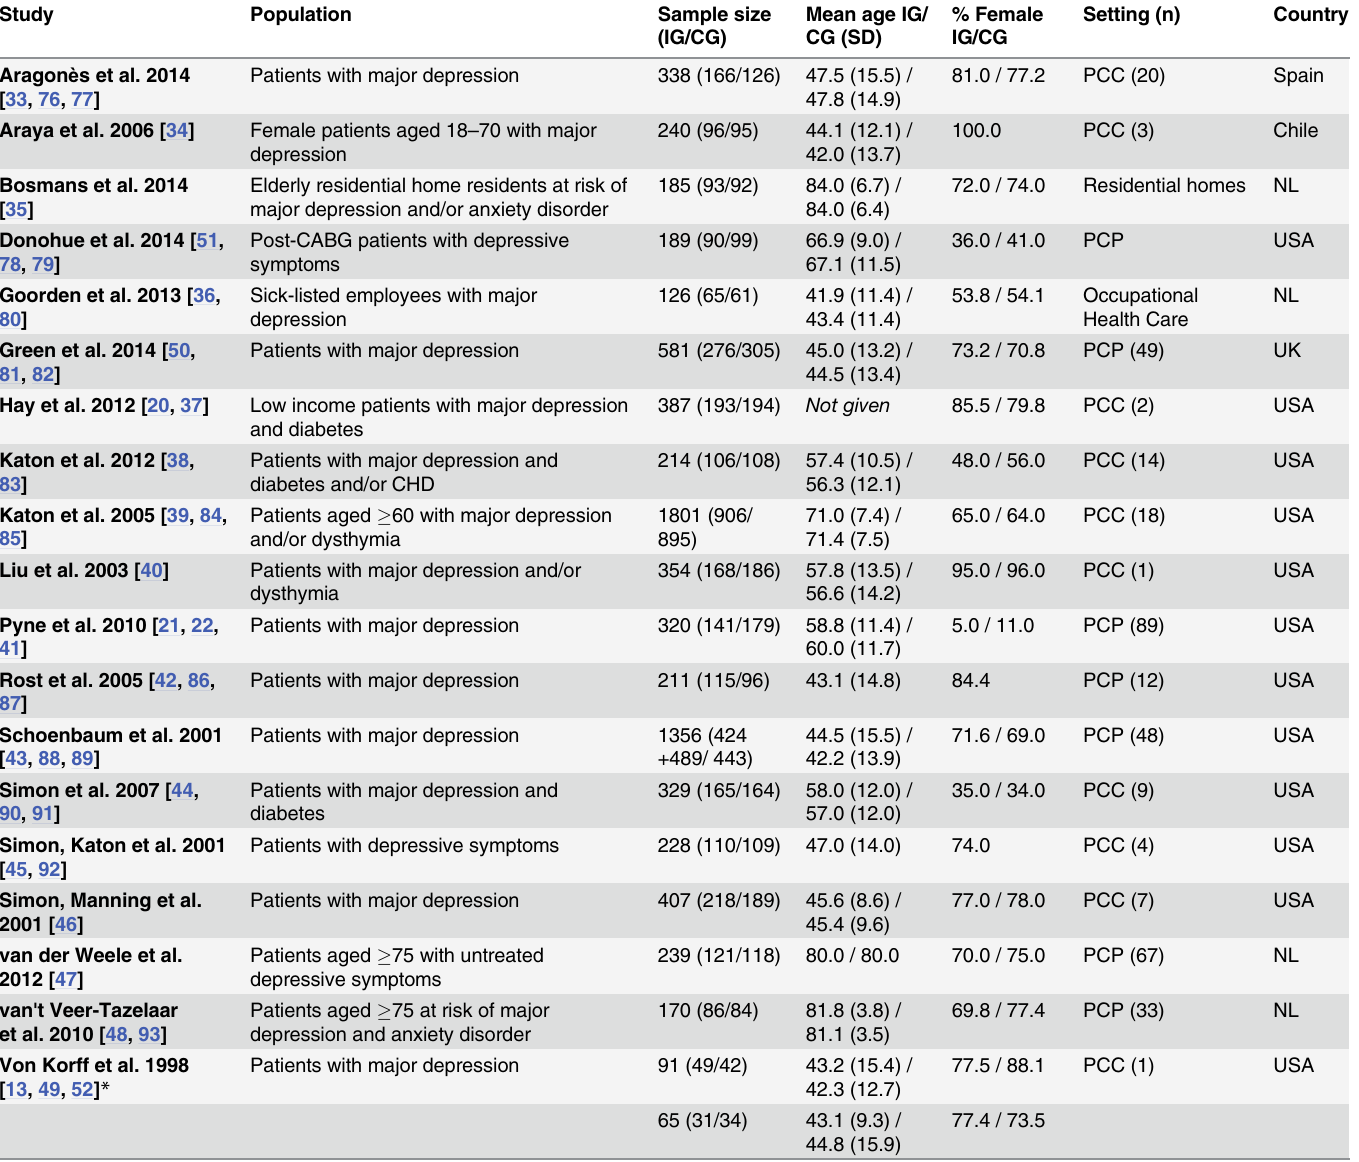
Table 1. General characteristics of the included